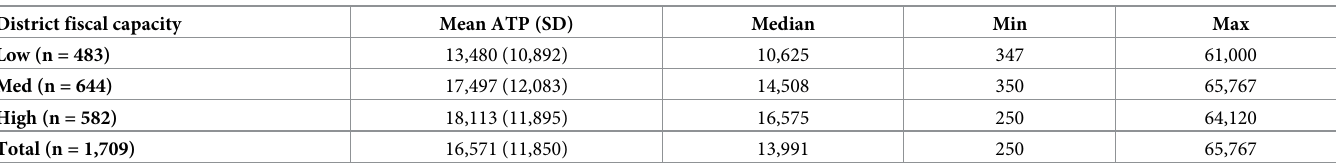
Table 4. Ability to pay per capita across district fiscal capacity.